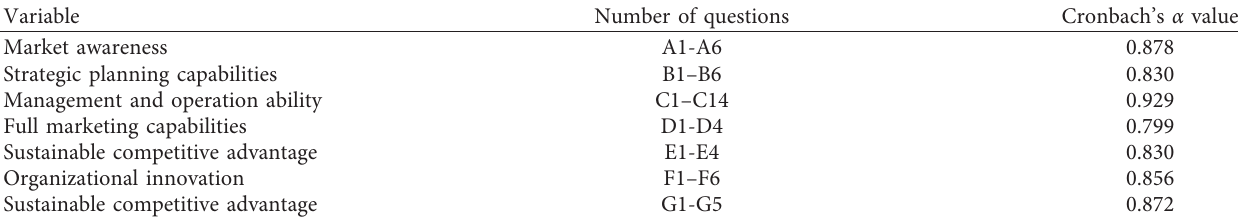
Figure 1: ANOVA results of control variables. Table 1: Results of the reliability test of the